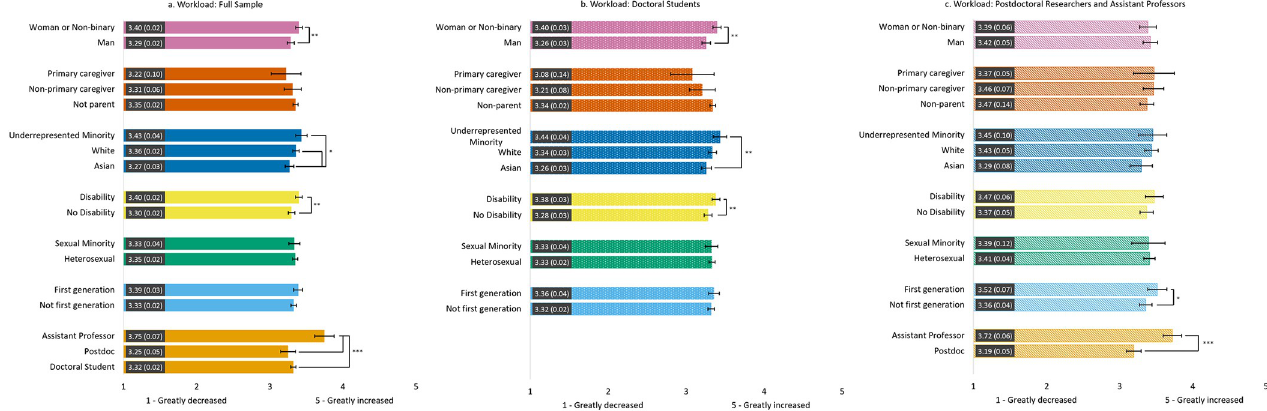
Fig 2. Estimated marginal means of reported change in workload due to the COVID-19 pandemic for the full sample (2a) and the doctoral student (2b) and postdoc/asst prof (2c) subsamples. Participants were asked to rate the degree to which their workload changed on a Likert scale from 1 = Greatly decreased to 5 = Greatly increased . Error bars represent the 95% CI. Numeric values in each bar are the estimated marginal mean and standard error. � indicates p < .05, �� indicates p < .01, and ��� indicates p < .001. See S4 Table in S1 File for results of each model.